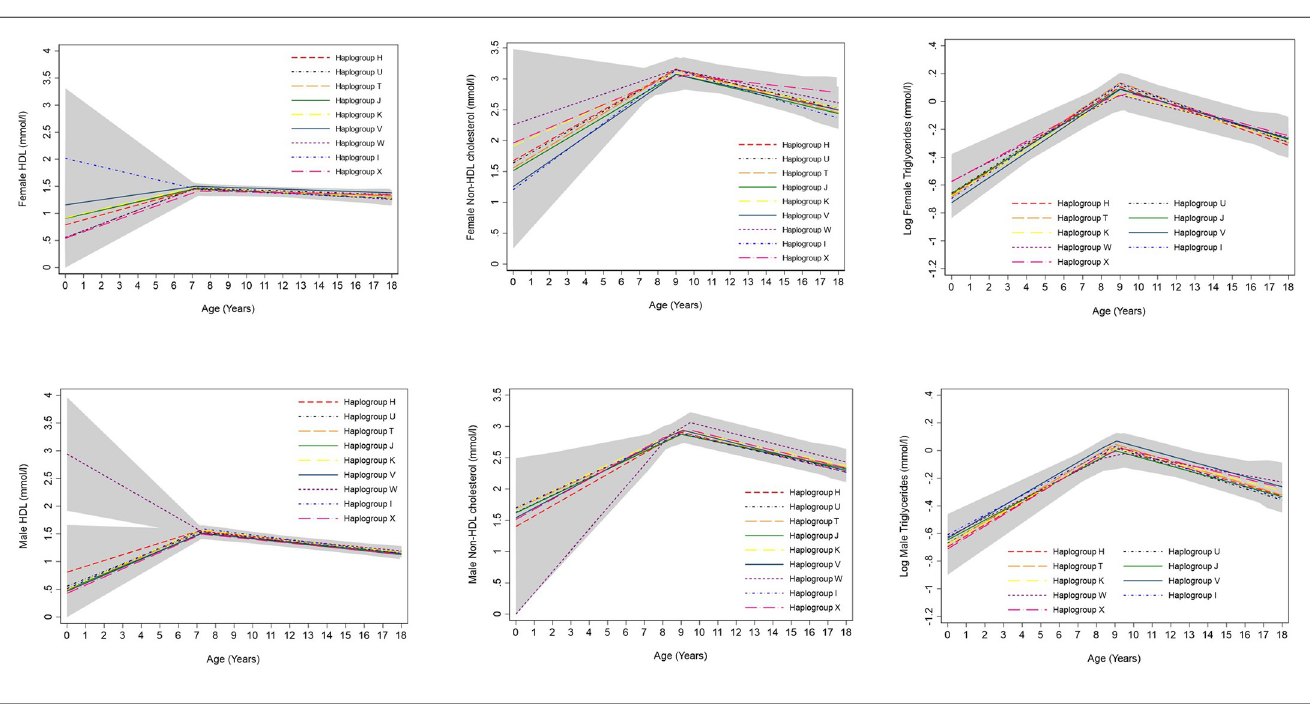
Fig 3. Mean trajectories of HDL-c, Non-HDL-c and log triglycerides in females and males, by haplogroup. 99% confidence intervals for all haplogroups are displayed in grey. Detailed results with confidence intervals are provided in S16 & S17 Tables in S1 File. Note the different age range on the X axis for each outcome. HDL-c, high density lipoprotein